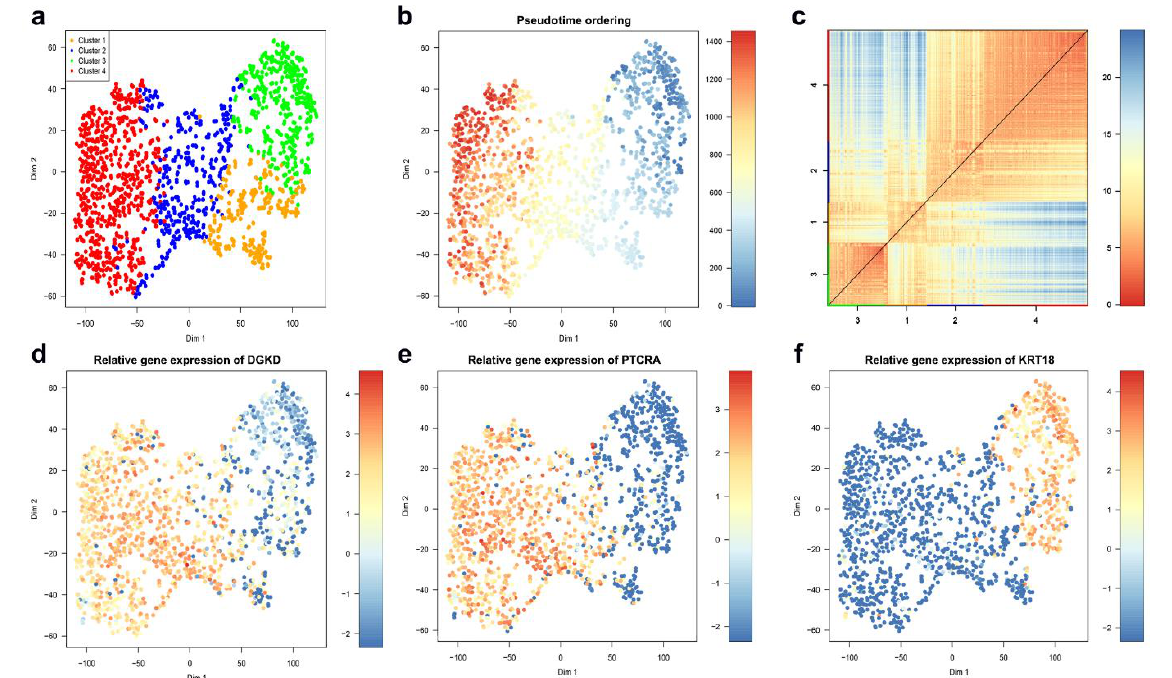
Figure 4. Identification of the CTC sub-populations, clustered based on the Golgi fragmentation gene list. ( a ) t SNE map visualizing clusters of circulating breast cancer cells identified with k -means clustering. ( b ) The plot from ( a ) with cells colored based on their pseudo-time ordering. ( c ) A heatmap portrayal of cell-to-cell distances; cluster centers were ordered by hierarchic clustering. ( d ) The plot from ( a ) with cells colored based on their DGKD expression. ( e ) The plot from ( a ) with cells colored based on their PTCRA expression. ( f ) The plot from ( a ) with cells colored based on their KRT18